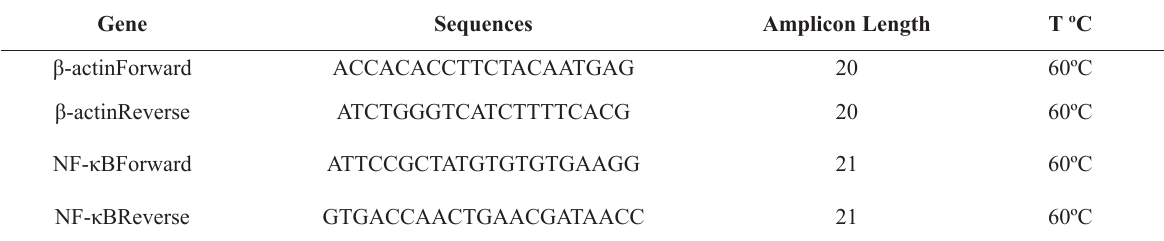
Primers design. The table shows the primer sequences, amplicon length and the annealing temperature.